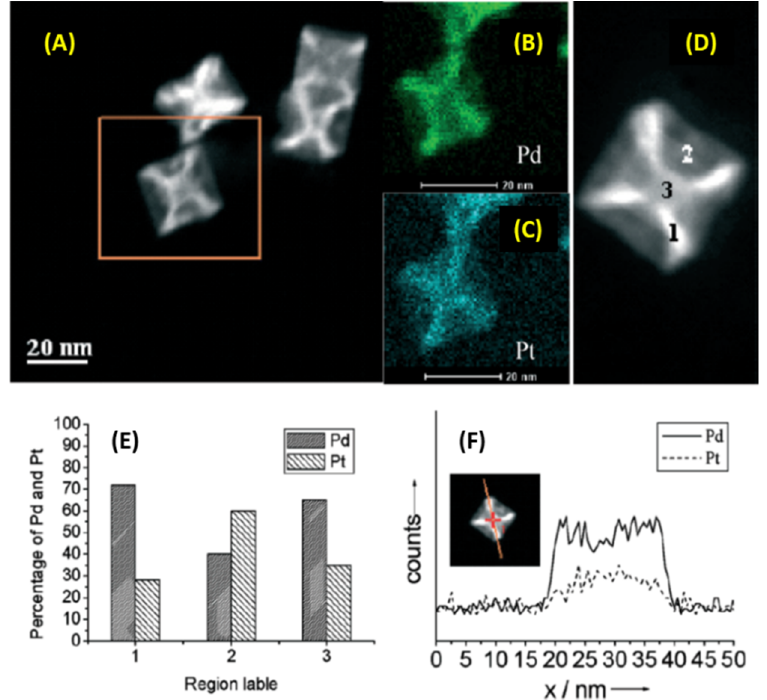
Figure 14. ( A ) HAADF-STEM image for Pd-Pt hypercube; ( B , C ) EDX mapping results for Pd and Pt respectively; ( D ) HAADF-STEM image of single hypercube for EDS analysis of three regions marked 1, 2, and 3; ( E ) plot of Pd and Pt % values for the three regions; ( F ) line-scanning profile along the single hypercube NP. Adapted with permission from the American Chemical Society. Copyright 2014 American Chemical Society.